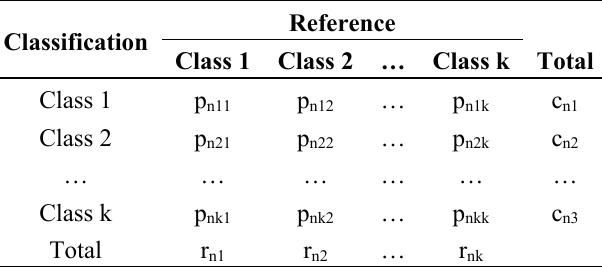
Table 2. Sub-pixel error matrix for the nth pixel.